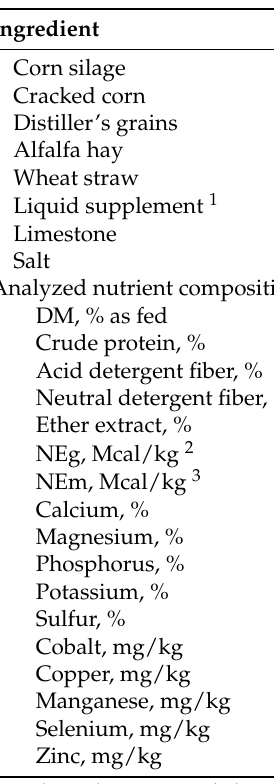
Table 1. Dry matter (DM) ingredient composition of basal